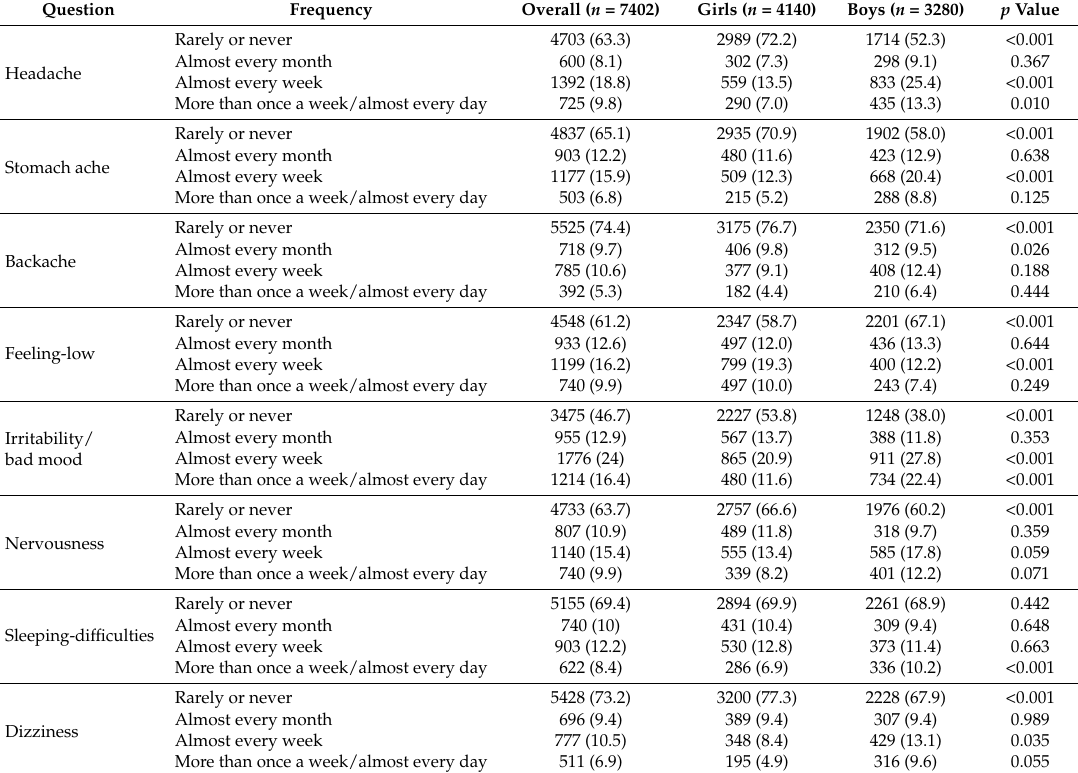
Table 2. Frequency of self-rated health status in a sample of schoolchildren from Bogot á , Colombia. The FUPRECOL